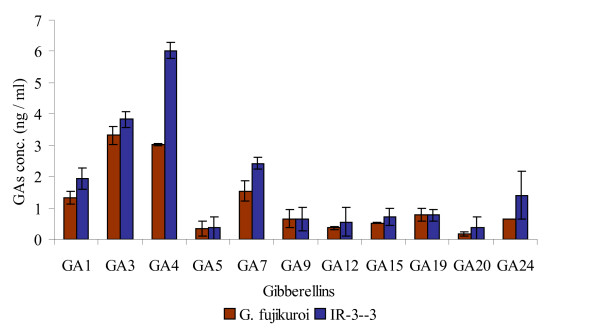
Gibberellins content of fungal isolate IR-3-3 and wild type G. fujikuroi. The experiment was performed in 3 replicates; standard deviation from means was calculated using MS-EXCEL. On GC-MS SIM analysis of culture filtrate extracts from IR-3-3, all four bioactive GAs were detected higher than of G. fujikuroi. Non-bioactive GAs including GA15, GA20 and GA24 were in comparatively higher amounts, GA9 and GA19 were in about equal amounts, while GA12 was detected in amount lower than in case of control (G. fujikuroi).